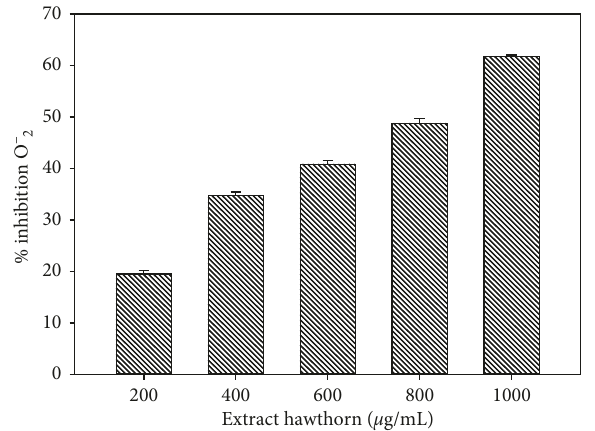
Figure 4: Effect of different concentrations of extracts from tejocote on the inhibition of superoxide radical generated by the xanthine-xanthine oxidase system. The results are shown as the mean ± SD ( n �